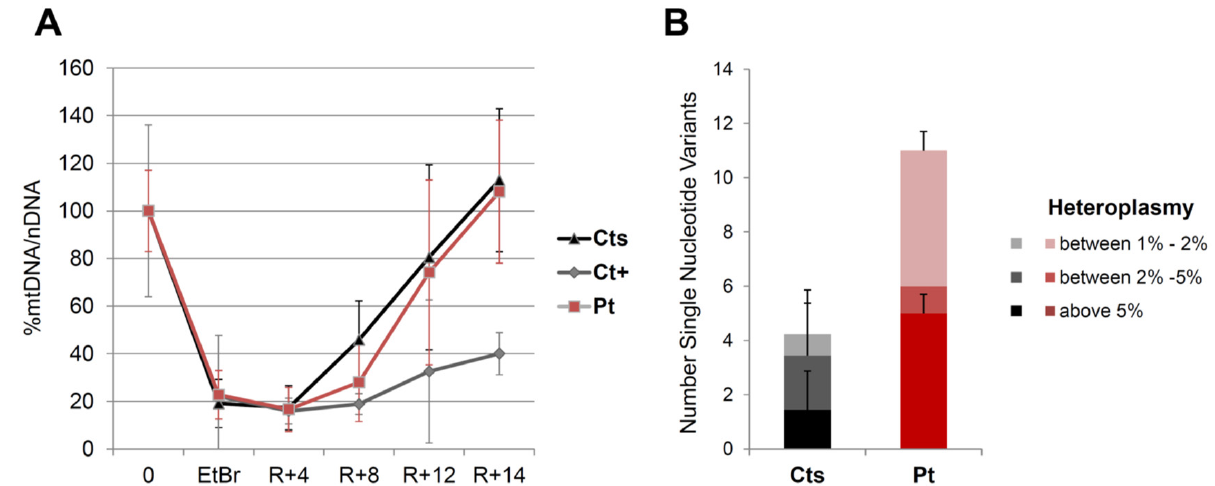
Figure 4. Functional studies on the patient’s fibroblasts. ( A ) Depletion/repopulation experiment in fibroblasts from the patient (Pt), a control individual (Ct) and a patient harboring biallelic RNASEH1 mutations (Ct+). Depletion was achieved with the addition of EtBr to the culture medium for 4 days (EtBr), and recovery was followed up for 14 days (R + 14) after the removal of the drug. The percentage of mtDNA/nDNA was determined by qPCR; for each subject, an initial value was set up to 100%, before starting treatment (0). ( B ) Number of heteroplasmic variants detected by NGS in whole mtDNA from the patient (Pt) and control individuals (Ct). Three different ranges of heteroplasmy were considered: above 5%, between 2 and 5%, between 1 and 2%.